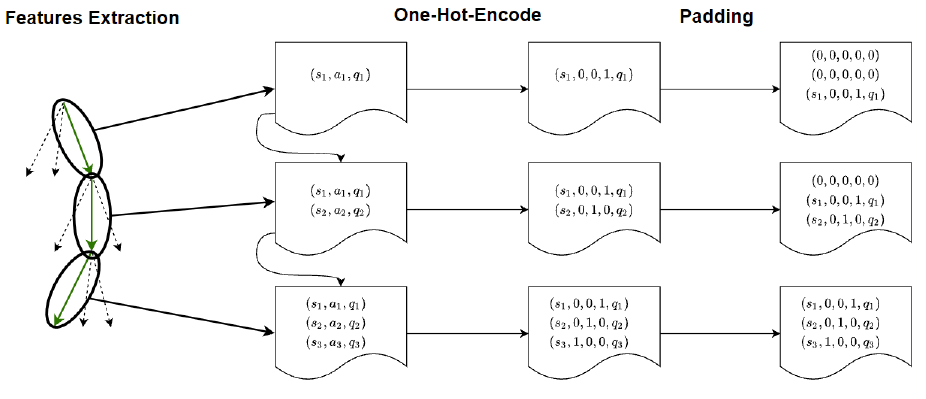
Figure 5. Creation of the dataset for the distal